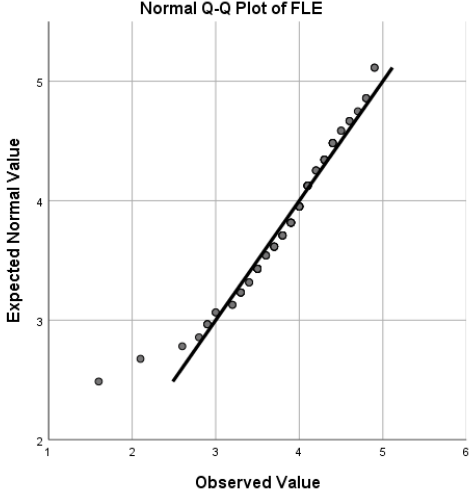
Figure 1. Quantile-quantile (Q-Q) plot for distribution of FLE scores.